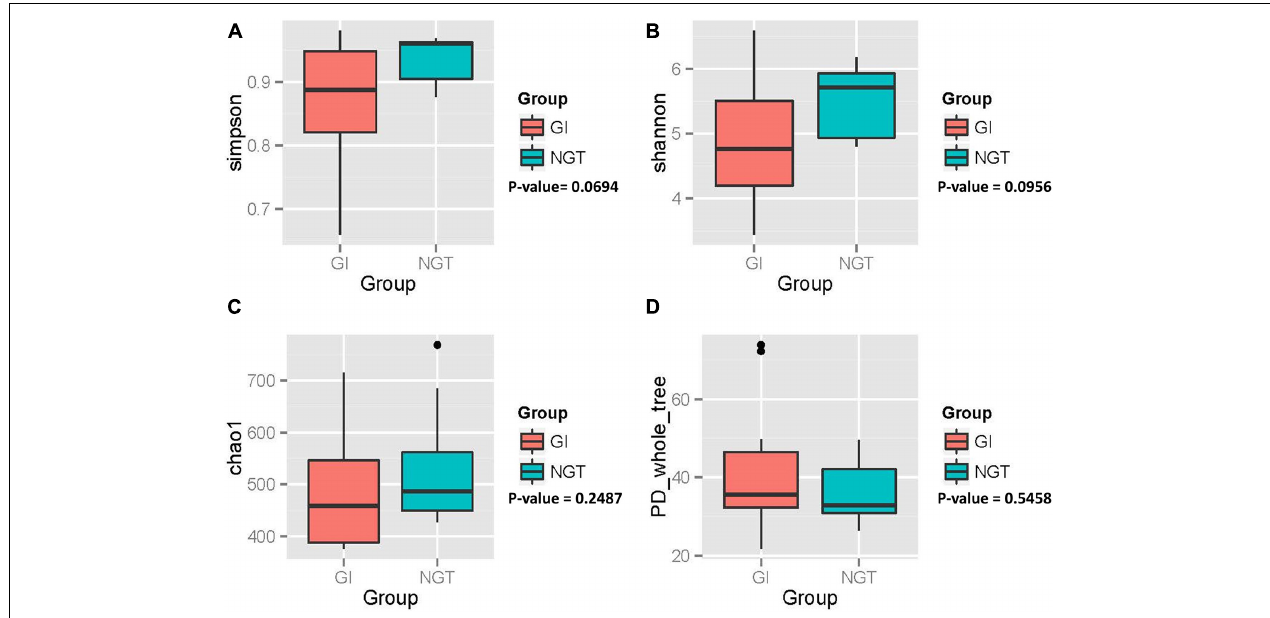
FIGURE 2 | Box plots showing the alpha diversity of the gut microbiota of post-GDM women in the GI and NGT groups. (A) Simpson index, (B) Shannon index, (C) Chao_1 index, and (D) PD_whole_tree index. p -value obtained from the non-parametric Wilcoxon test. p -value < 0.05 was considered as statistically significant. GDM, gestational diabetes mellitus; GI, glucose intolerance; NGT, normal glucose tolerance; PD, phylogenetic